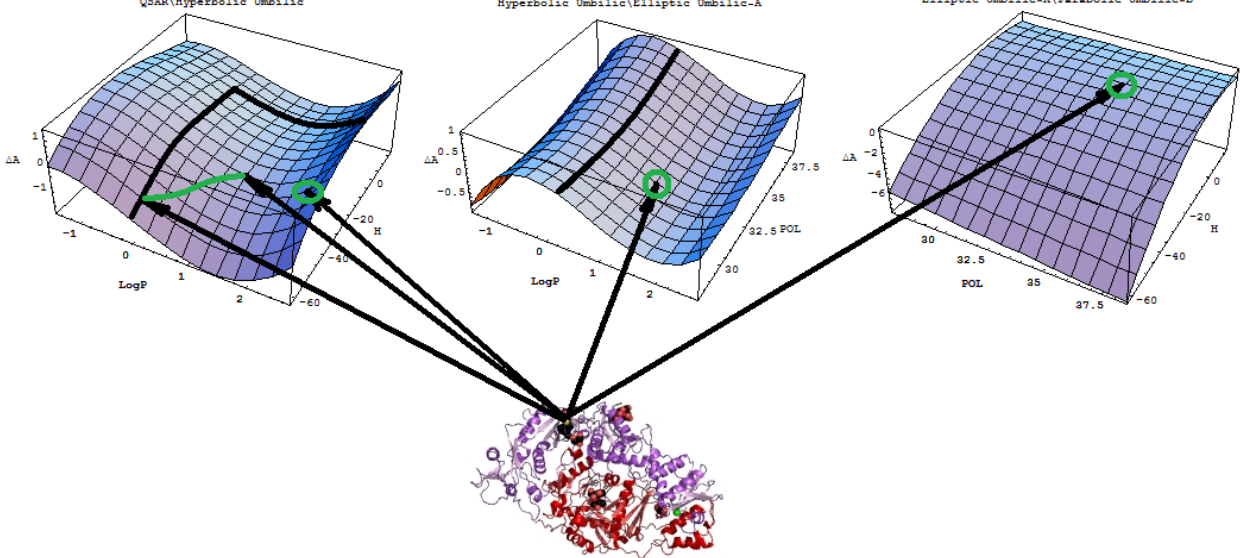
Figure 3. Determination of the structural domains of pyridinone-derivative type non-nucleoside reverse transcriptase inhibitors in the same range of structural descriptors by employing the principles of hydrophobicity, minimum polarizability, binding energy, and the minimum difference between the polynomial activity models of Figure 2; the hydrophobic pocket was identified in the p66 subunit of HIV-1-rt of specific transferase R221239